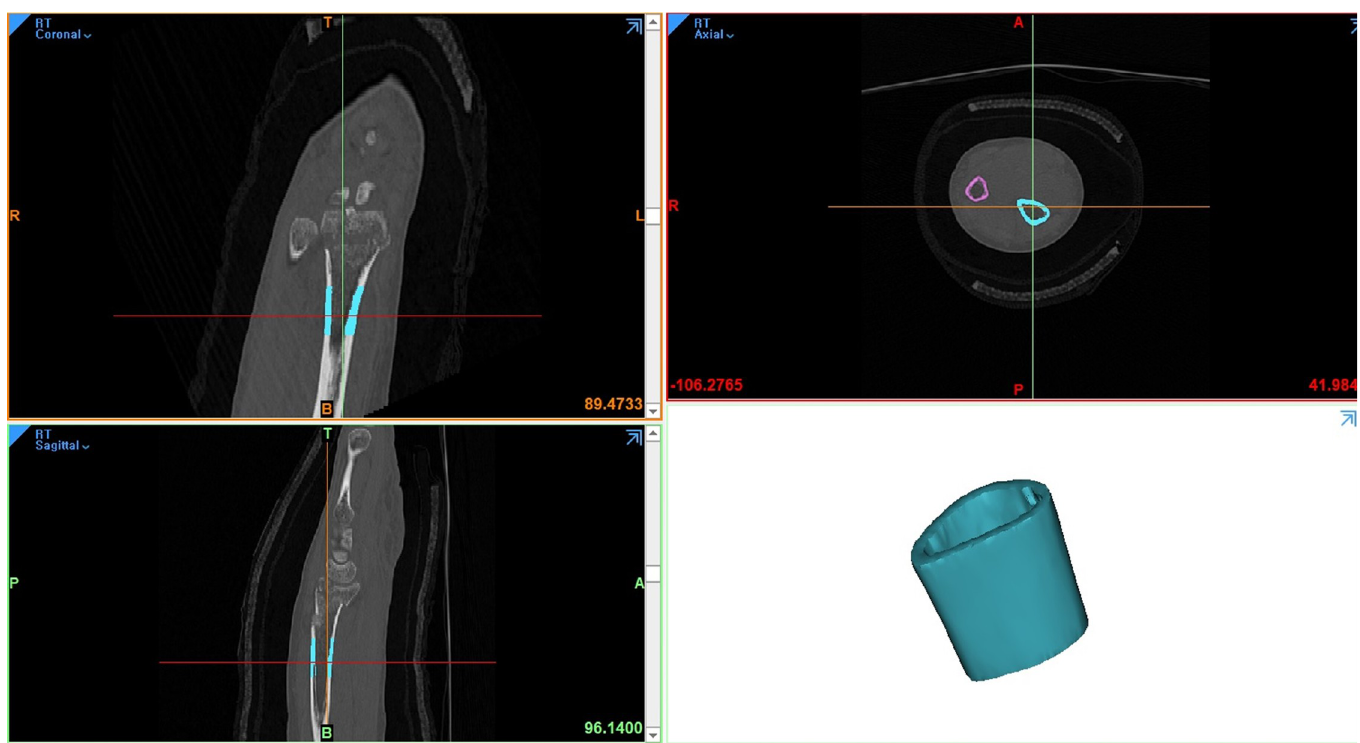
Fig 3. Region of Interests (ROI) of the radial forearm cortical bone. A 2 cm long cylindrical mask was created 3 cm proximal to the lunate fossa of the radius (A blue cylinder). The ROI of the radial forearm cortical bone mask defined.